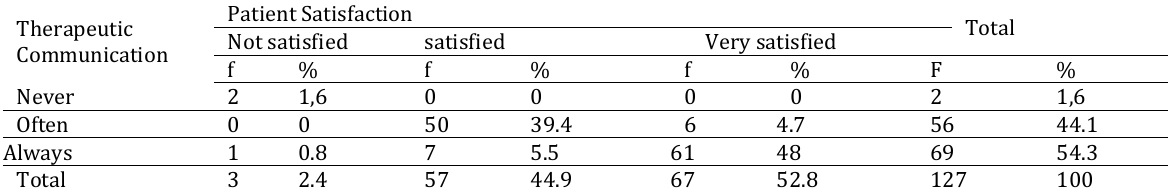
Bivariate Analysis Table 4. Cross Table of Relationships between Therapeutic Communication and Post-Operation Patient Satisfaction in the ward on December 2018 (n = 127) Therapeutic